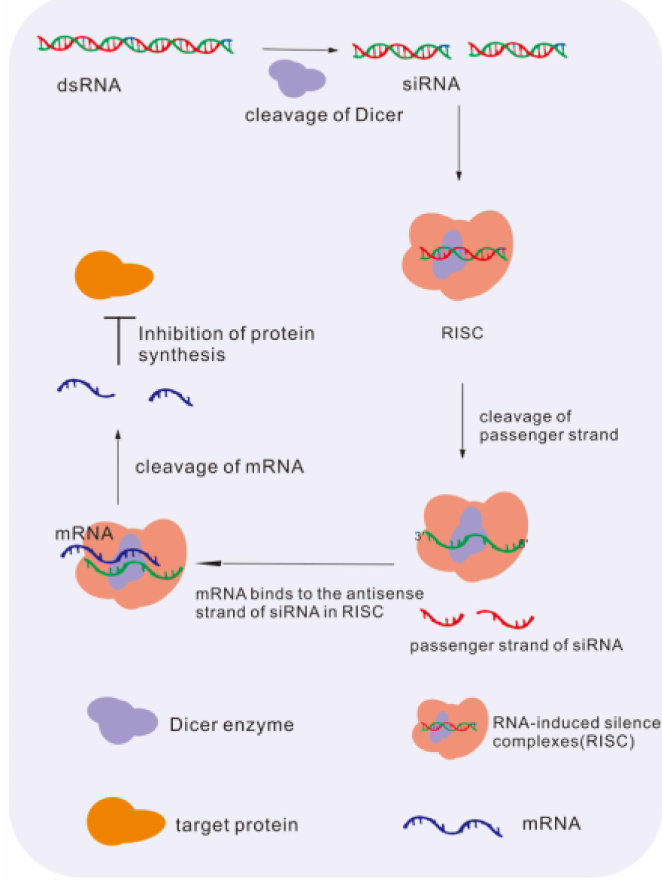
Figure 4. The mechanism of siRNA downregulates levels of gene. dsRNA is cleaved by the dicer enzyme to siRNA. siRNA merges into the RISC complex and binds to target mRNA for degradation. At last, the synthesis of protein is inhibited